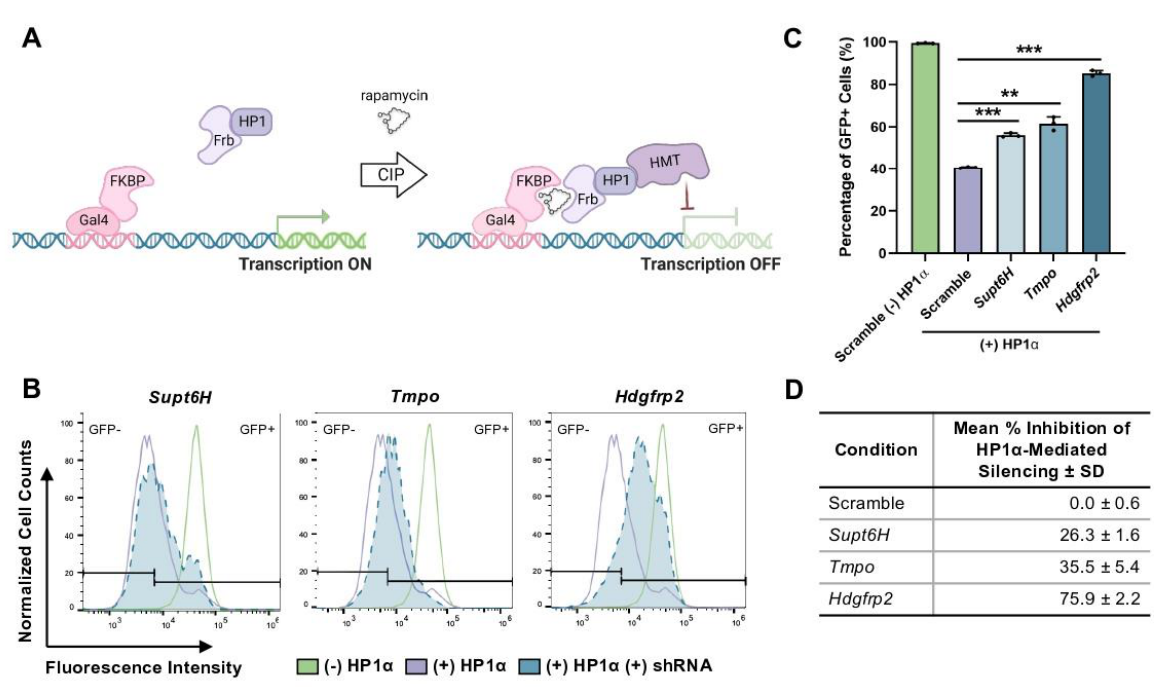
Figure 1. Hdgfrp2 knockdown inhibits HP1 α -mediated gene repression. ( A ) Schematic overview of the Chromatin in vivo Assay, or CiA system. A Gal4 binding site lies just upstream of the GFP reporter, which allows Gal4-FKBP to be recruited to the reporter locus. The addition of rapamycin initiates CIP between Frb-csHP1 α and Gal4-FKBP, resulting in HP1 α -mediated GFP repression. ( B ) CiA:mESCs containing inducible shRNA constructs targeted against Supt6H , Tmpo , and Hdgfrp2 were induced with 1 µ g/mL doxycycline for 48 hrs +/ − 6 nM rapamycin. Flow cytometry histograms represent fluorescence intensity levels of shRNA-targeted cells (blue) during active CIP-HP1 α recruitment compared to nonsense (scramble) shRNA control cells with (purple) and without (green) CIP-HP1 α recruitment. ( C ) Mean percentages of GFP+ cells after 48 h of treatment with doxycycline: Scramble (-) HP1 α = 99.4 ± 0.2; Scramble (+) HP1 α = 40.7 ± 0.4; Supt6H (+) HP1 α = 56.1 ± 1.0; Tmpo (+) HP1 α = 61.5 ± 3.2; Hdgfrp2 (+) HP1 α = 85.2 ± 1.3. Statistical significance was calculated using an unpaired t -test ( n = 3; ** p ≤ 0.01, *** p ≤ 0.001). ( D ) Mean % inhibition of HP1 α -mediated